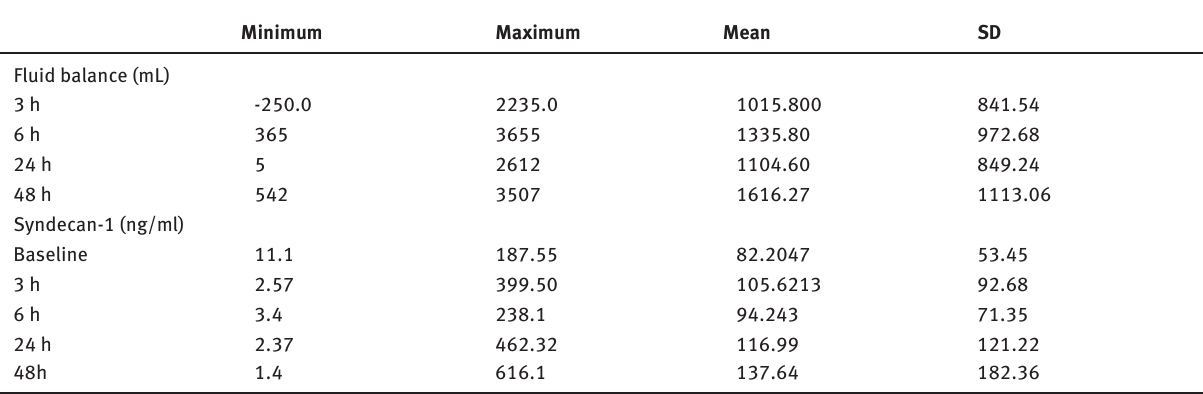
Table 2: Changes in plasma syndecan-1 concentrations and fluid balance over time (n=15)